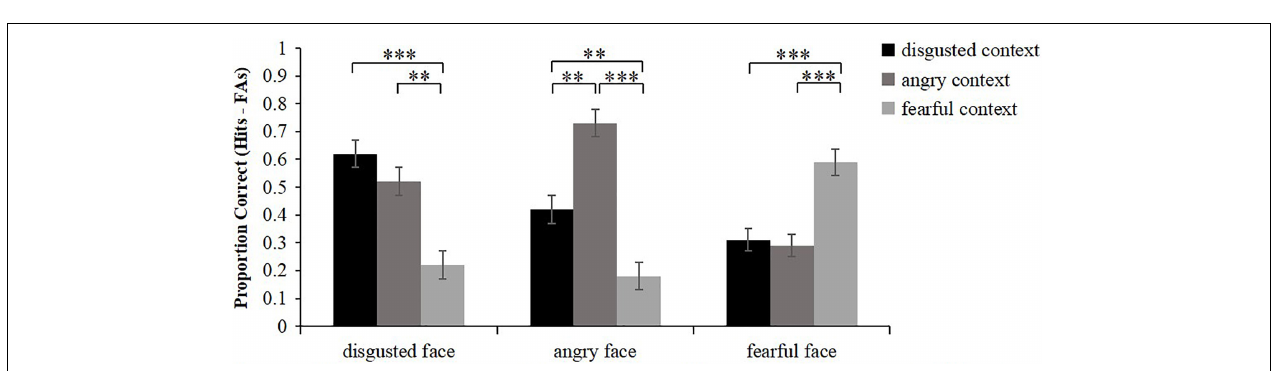
FIGURE 2 | Mean proportion correct for face recognition scores (hits minus false alarms) as a function of emotional face and emotional context. Error bars represent standard error. ∗∗ p < 0.01, ∗∗∗ p < 0.001.